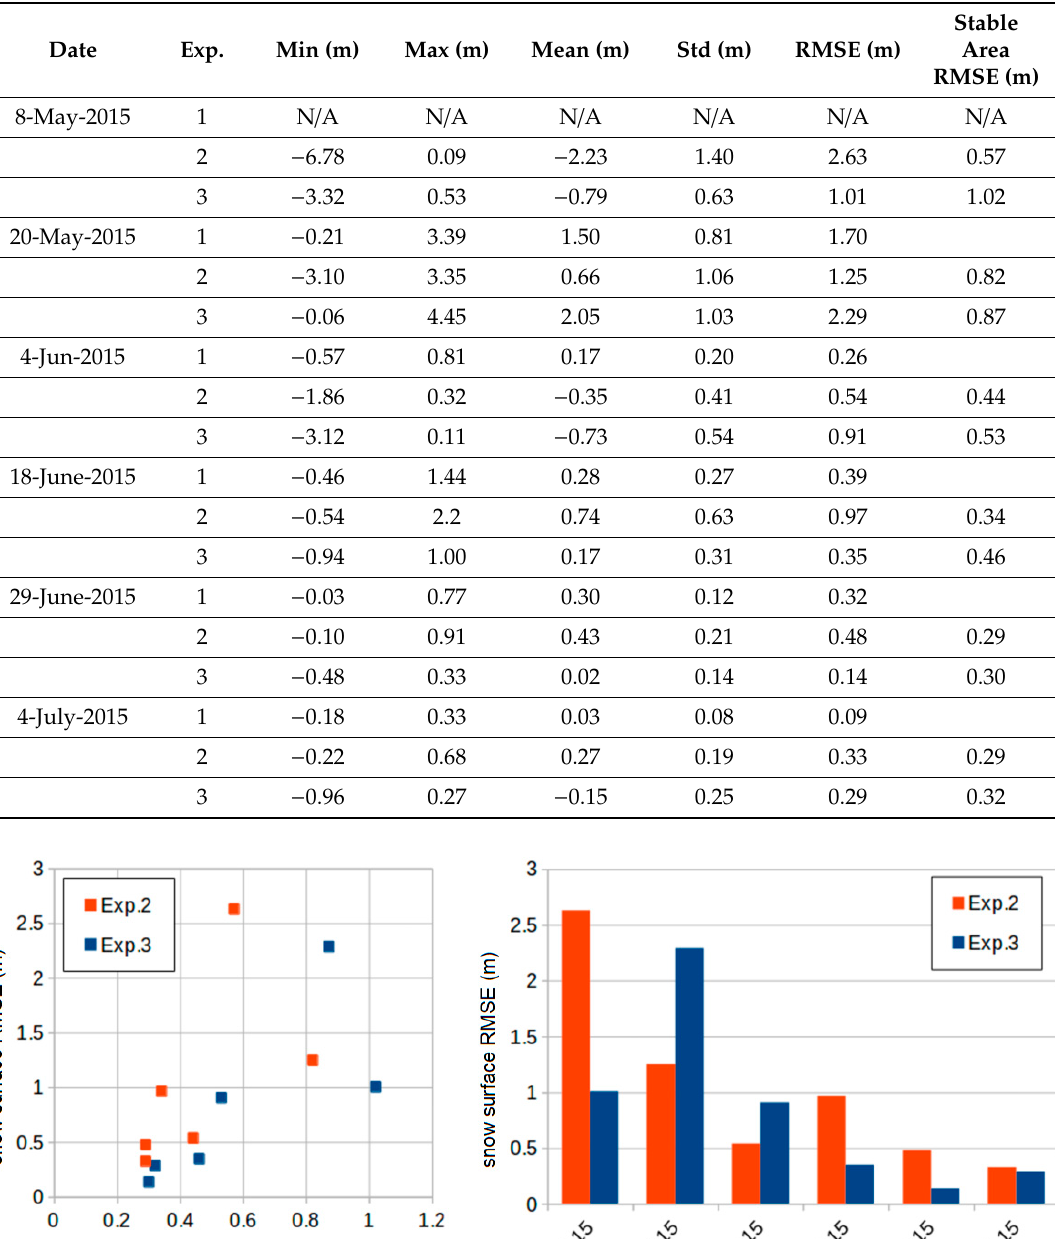
Table 3. Statistics of the residuals between the snow-on DEMs and the field measurements. The RMSE over the stable area is provided as an indicator of the performance of the ICP adjustment. The results are not available for Exp. 1 because the GCPs were covered by the snow are thus not visible in the photographs.